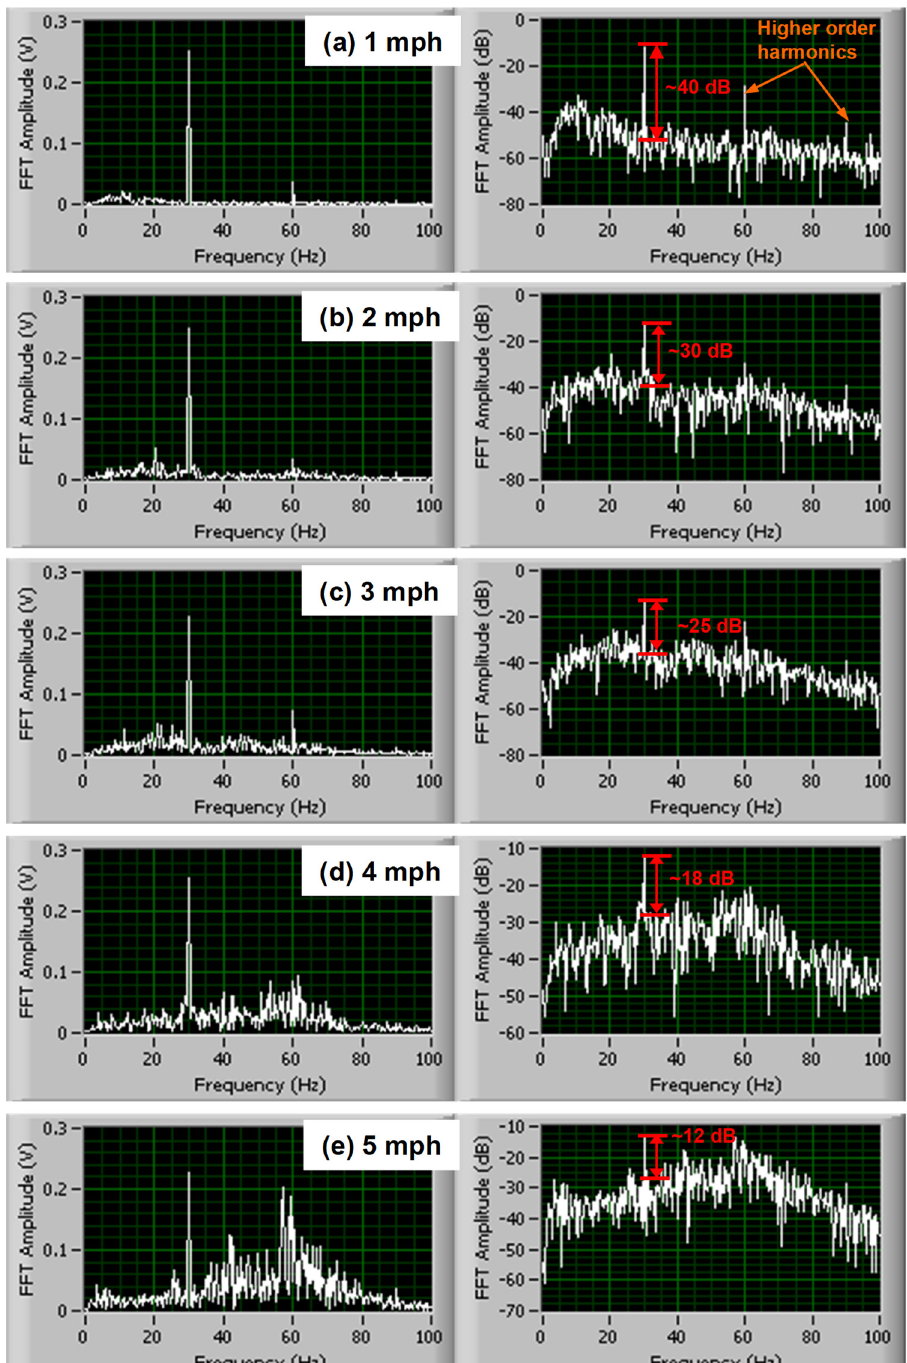
Figure 4. Signal-to-noise ratio (SNR) and rolling noise with varied test speeds (5 s window) (note: new rolling sensor (Sensor #1), 5 psi sensor hold-down pressure, RDD operating frequency of 30 Hz, and 3 kip peak dynamic loading). ( a ) 1 mph; ( b ) 2 mph; ( c ) 3 mph; ( d ) 4 mph; ( e ) 5 mph.